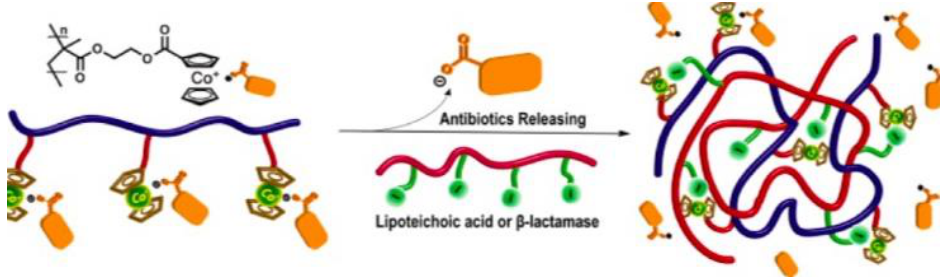
Figure 11. Antibiotic release from antibiotic-metallopolymer ion-pairs via lipoteichoic acid or β -lactamases. Reproduced with permission from reference [169]. Copyright 2014 ACS.